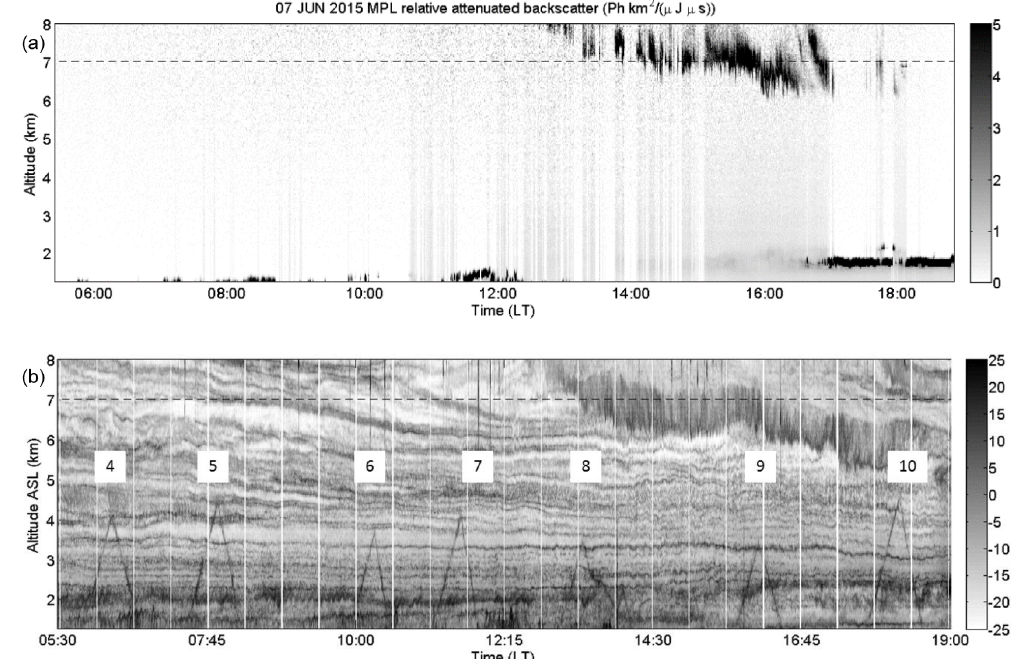
Figure 2. (a) Time–height plot of MPL normalized relative backscatter (countskm 2 µJ − 1 µs − 1 ) from 05:30 to 19:00LT on 7 June 2015. (b) The corresponding image of MU Radar echo power P v (dB, arbitrary level) at vertical incidence. The labels 4 to 10 indicate the UAV flights, whose tracks are clearly visible as triangles in the lower part of the